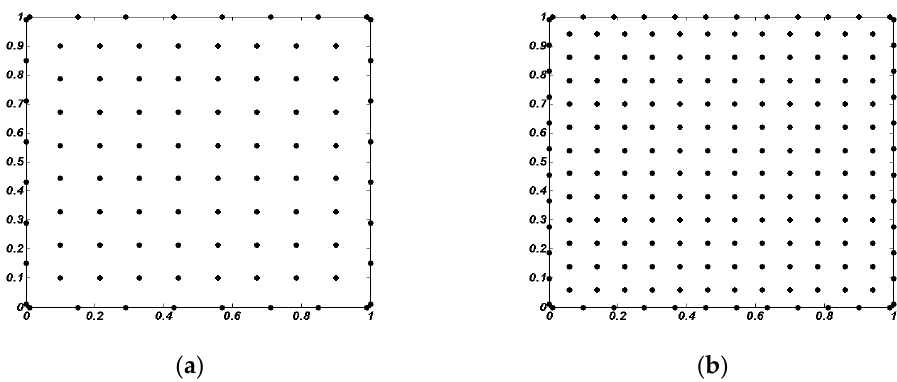
Figure 4. Clouds ( a ) 8 × 8 in a domain and ( b ) 12 × 12 in a domain.